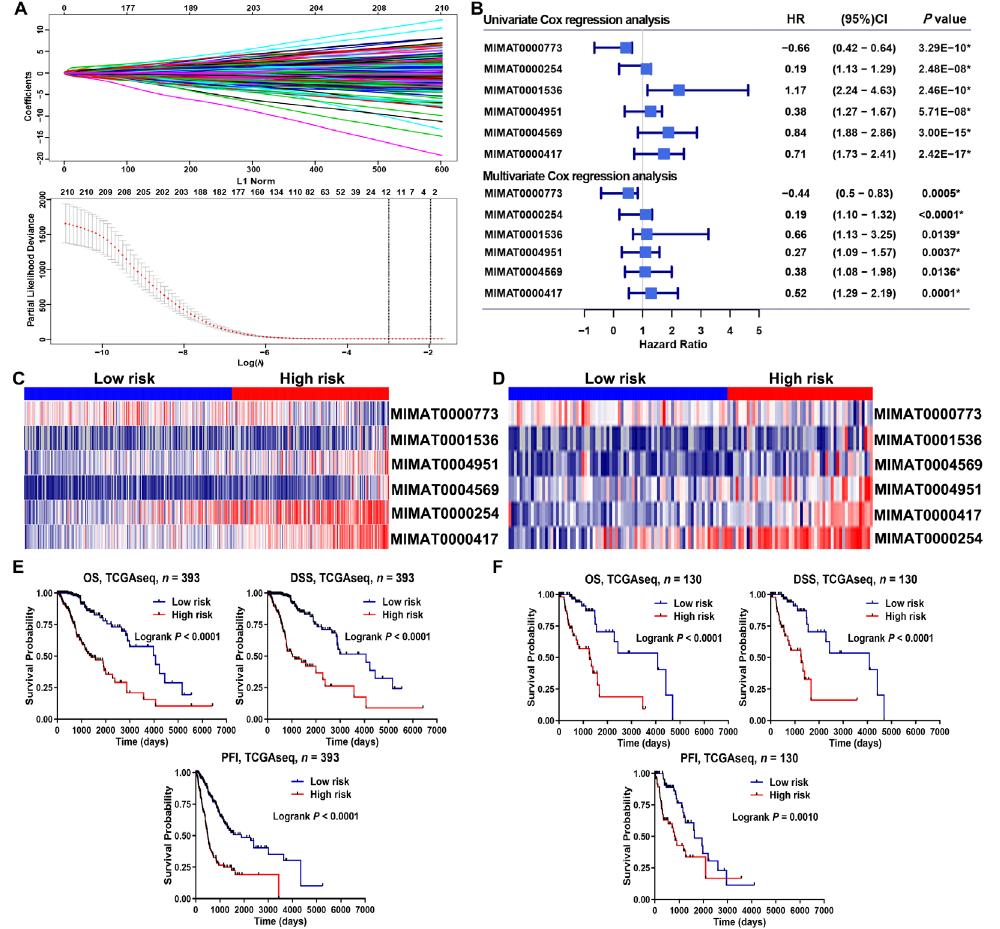
Figure 3. Risk model for LGG patients based on m 6 A-related miRNAs. (A) LASSO regression analysis using 10-fold cross-validation; (B) univariate and multivariate Cox regression analysis showed six independent prognostic miRNAs; (C, D) heat plots displayed the expression of six m 6 A-related miRNAs in the training and validation cohorts; (E, F) Kaplan-Meier analysis of the prognosis in the low-risk and high-risk groups. HR: hazard ratio; CI: confidence interval; * statistical significance Table 1. Characteristics of LGGs in the training and validation cohorts